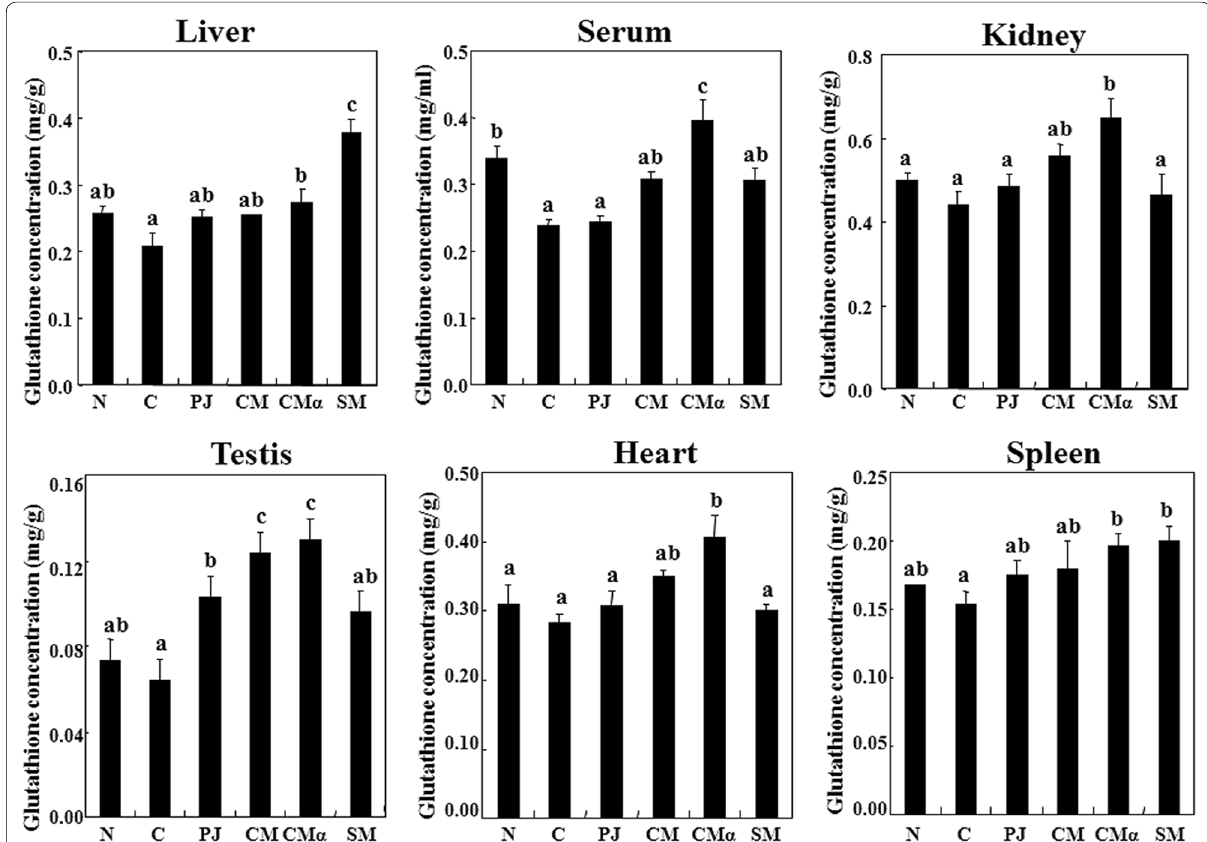
Fig. 4 Concentrations of glutathione (GSH) in the serum, hepatic homogenate, kidney, heart, spleen and